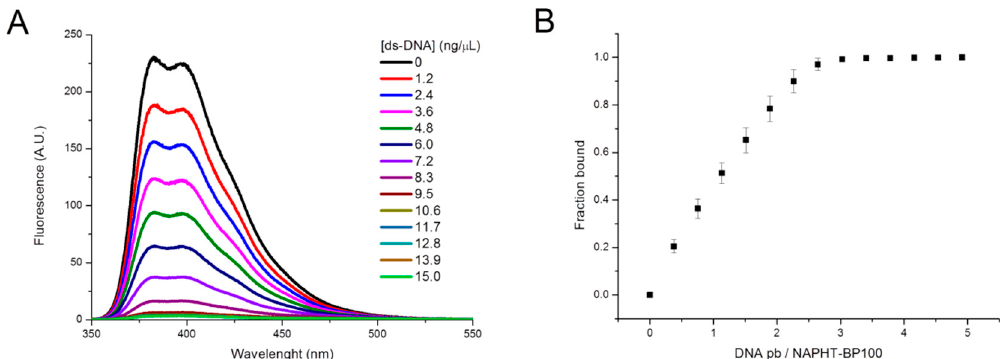
Figure 3. Analysis of NAPHT ‐ BP100/ds ‐ DNA binding. ( A ) Fluorescence spectra of NAPHT ‐ BP100 in solution and at different concentrations of ds ‐ DNA in Tris ‐ HCl 10 mM, pH 7.4, buffer. ( B ) Binding curve of NAPHT ‐ BP100 to ds ‐ DNA in 10 mM Tris ‐ HCl buffer, pH 7.4. The peptide concentration was 5 μ M and temperature 25 °C.